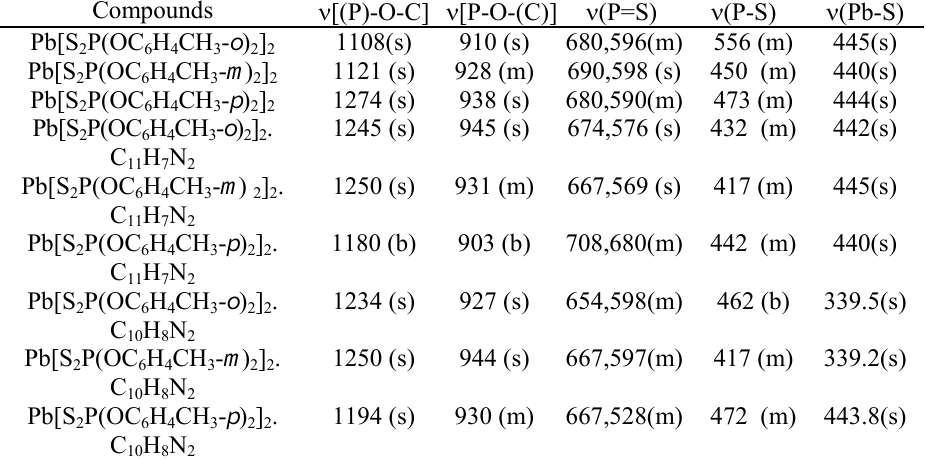
Table 1. IR spectral data of lead(II)bis{ O,O’ -ditolyldithiophosphates} complexes